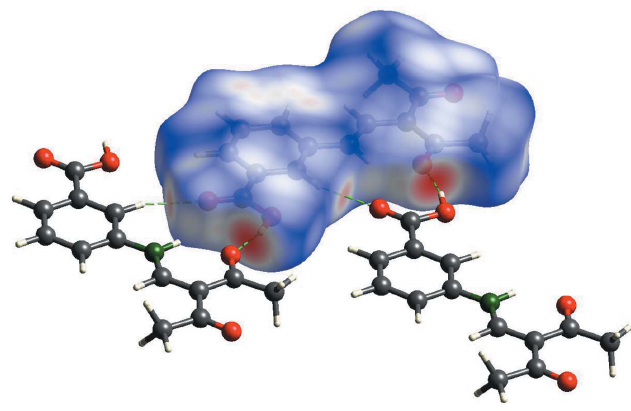
Figure 9 View of the Hirshfeld surface of 2 mapped over d norm in the range (cid:5) 0.712 to 0.973 au showing intermolecular hydrogen bonds as green dashed lines.